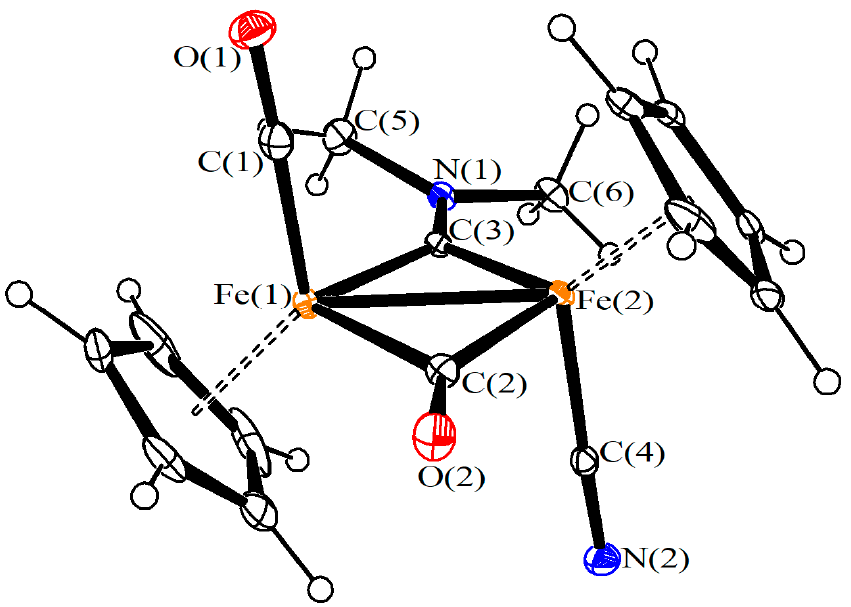
Figure 3. View of the molecular structure (ORTEP drawing) of trans -6b . Displacement ellipsoids are at the 30% probability level. Selected bond lengths (Å) and angles (°): Fe(1)–Fe(2) 2.5166(4),